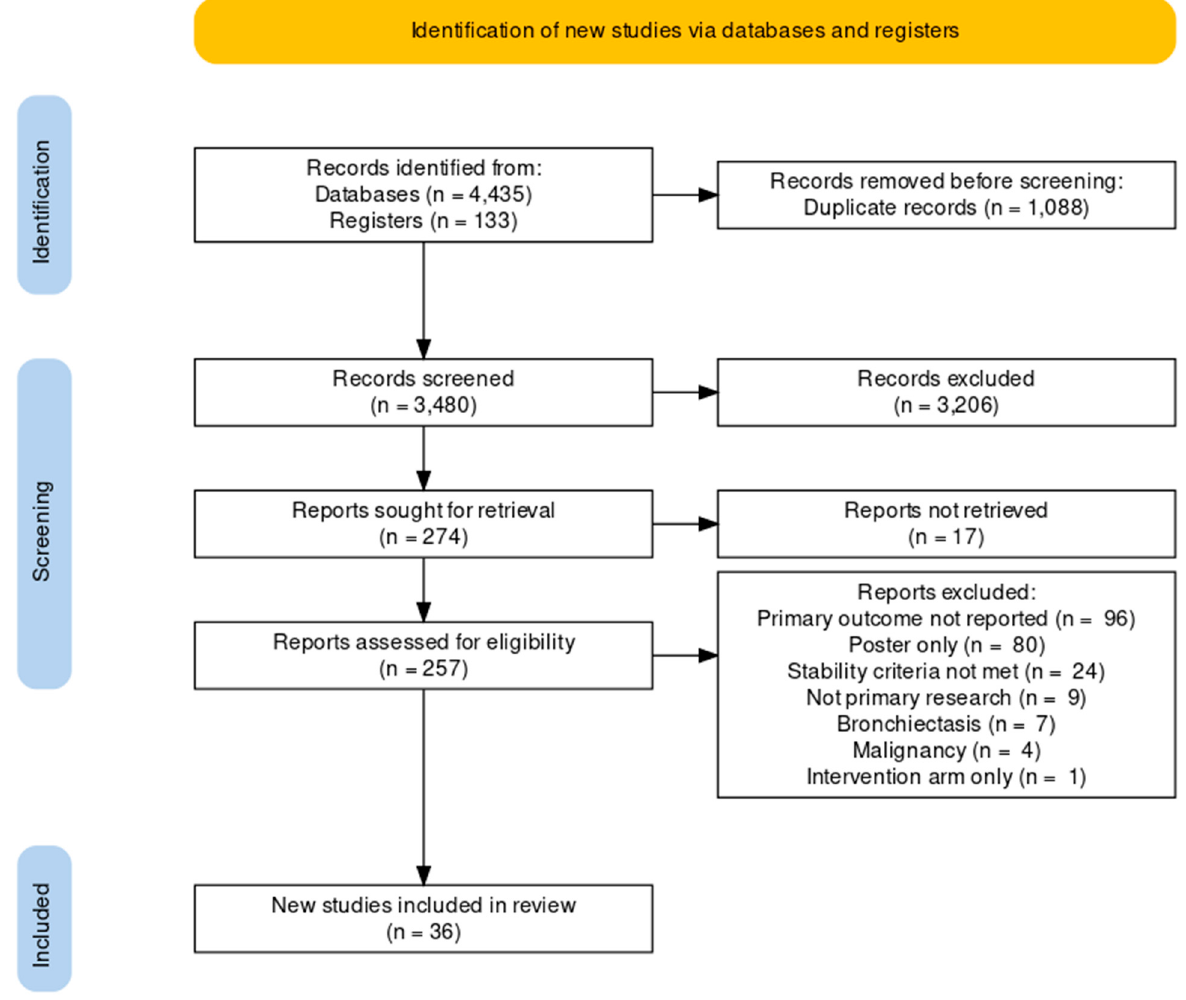
Figure 1. Preferred Reporting Items for Systematic Reviews and Meta-Analyses (PRISMA) flow chart of study selection and inclusion.